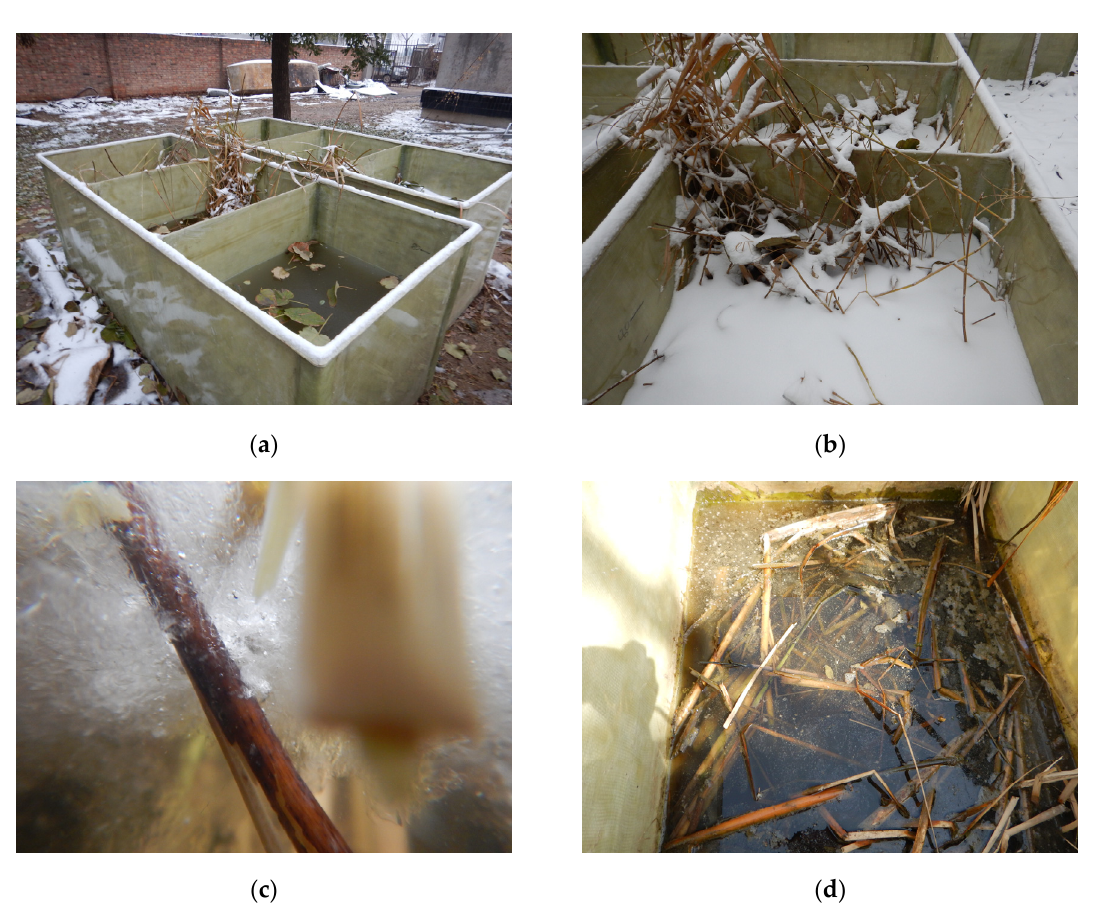
Figure 1. ( a ) On 22 November 2015, the water surface of mesocosms began to freeze. ( b ) On 25 November 2015, the water columns of mesocosms were under snow and ice cover. ( c ) On 1 December 2015, P. australis decomposed under ice. ( d ) On 20 March 2016, the decomposition of T. orientalis in the mesocosm after ice-off was incomplete.